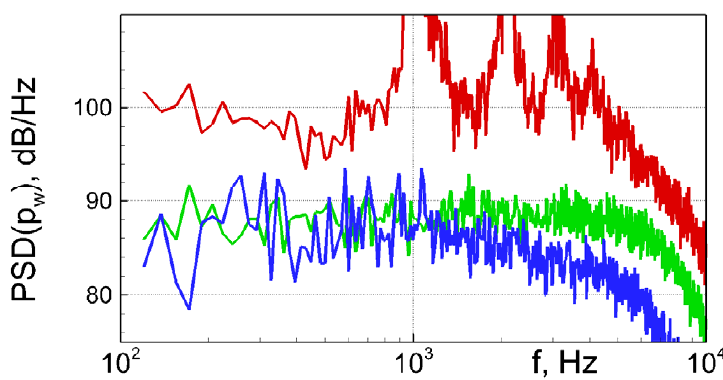
Figure 9. Instantaneous fi elds of fl uctuations of vertical (normal to the lined wall) velocity at x = 0.6 m from WMLES of fl ows in the duct with solid walls using original governing equations ( a ) and in the duct with liner using equations with added stabilization body force SRC1 (7) at B D = 0.4 ( b ).